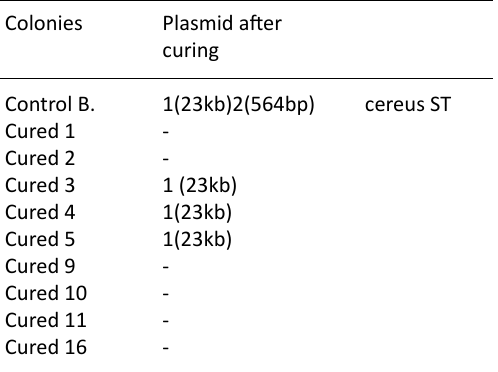
Fig. 13. The growth of B . cereus ST on agar plate supplemented with CdCl and Pb (NO ) of single colonies after Table 7. CdCl 2 3 2 elevated temperature of B. cereus